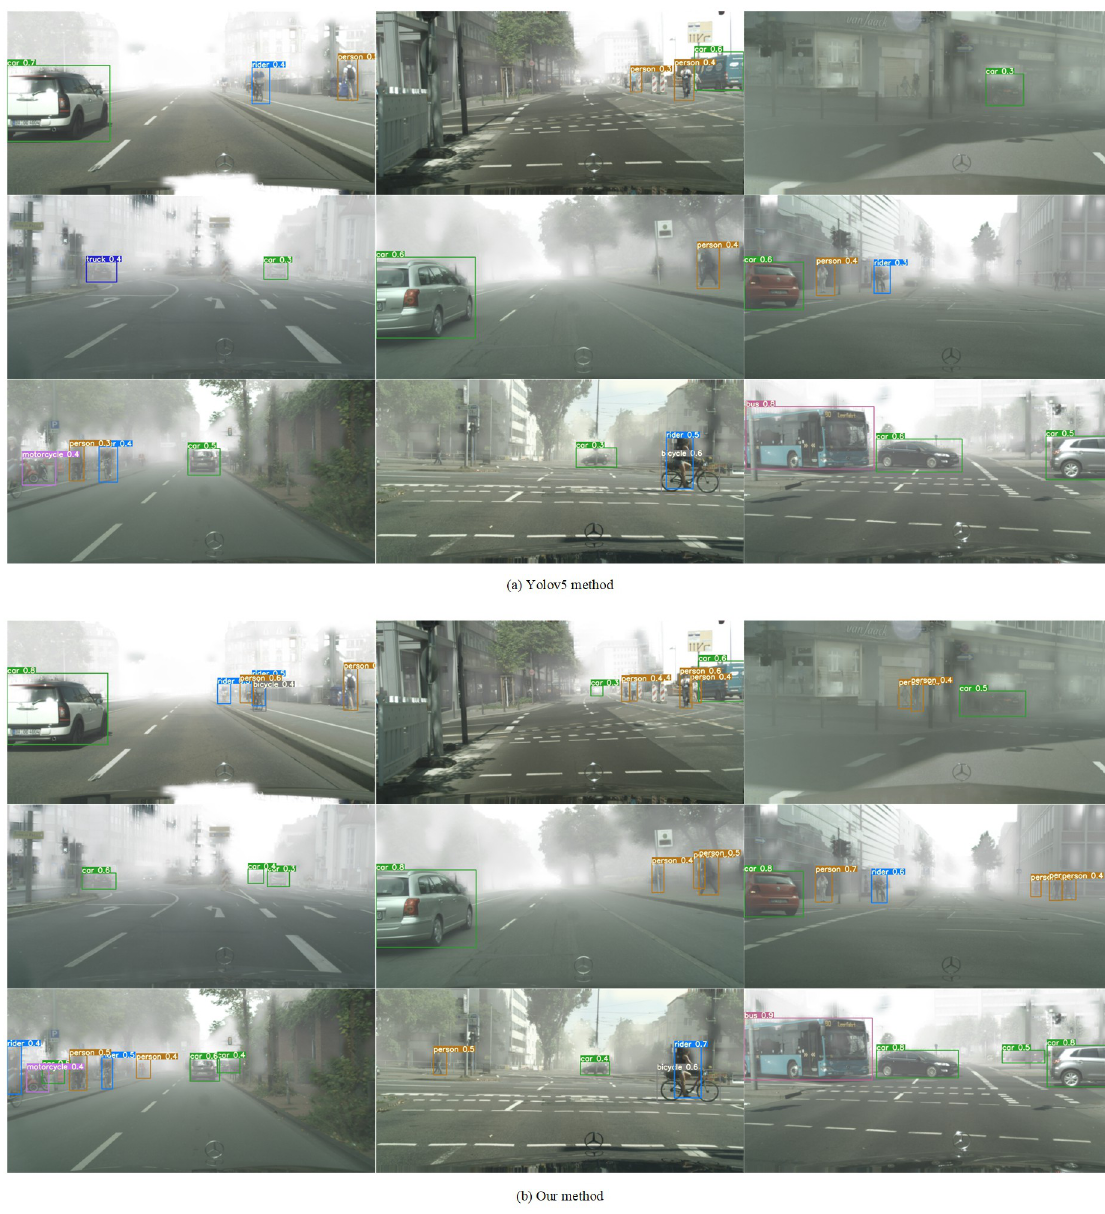
Fig 7. Visualization results on the Cityscape to Foggy